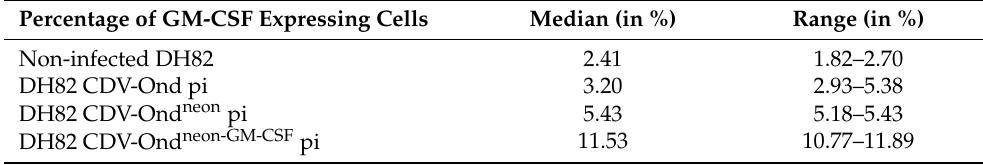
Table 4. Median and range of cells expressing GM-CSF as determined by immunofluorescence. Percentage of GM-CSF Expressing Cells Median (in %) Range (in %) Non-infected DH82